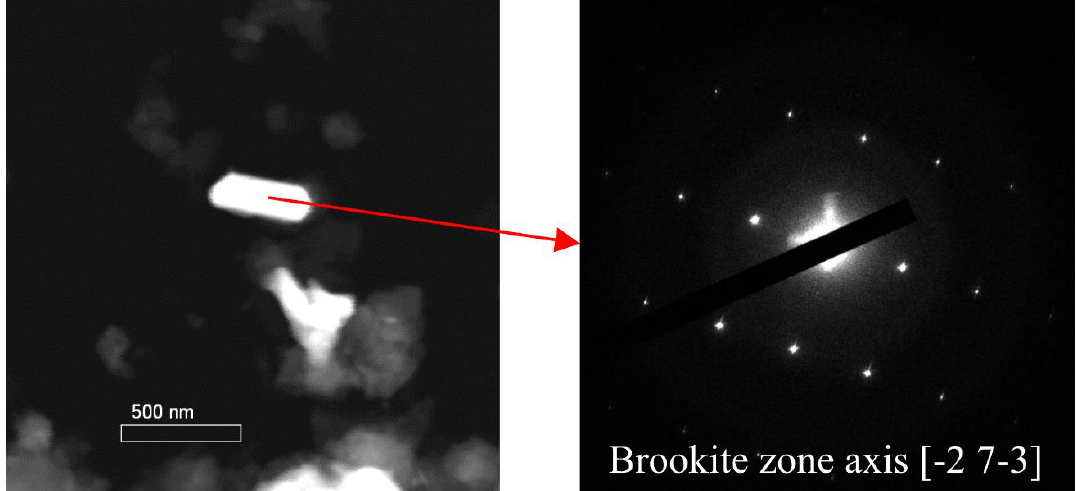
Figure 6. Image obtained using HR-TEM in HAADF scanning mode of a natural TiO 2 particle extracted from S2, and the corresponding electron diffraction pattern.